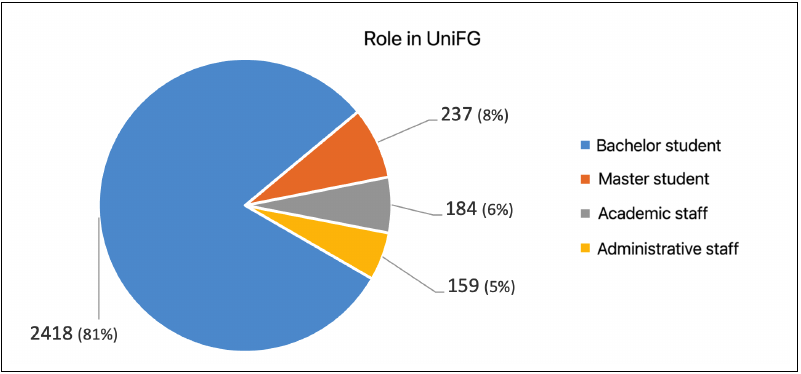
Figure 8. Roles of